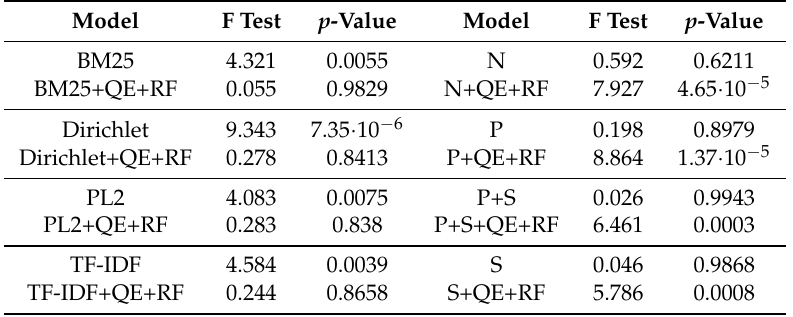
Table 28. T1: ANOVA test results for the different models and indexes for P@10.